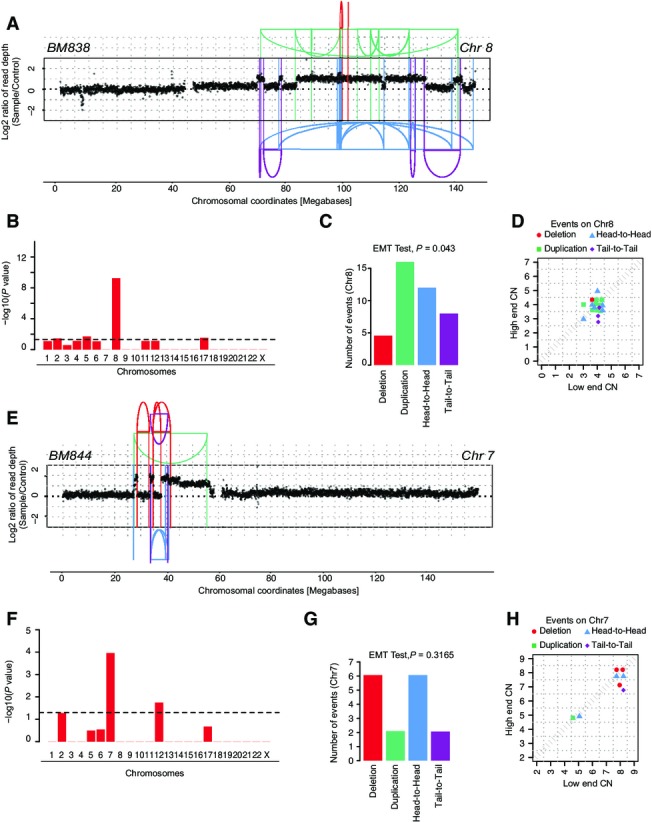
Analysis of chromothripsis cell lines identified post-Zeocin treatment and agar selection
In BM838, derived from hyperploid C29 clone, chromothripsis was observed on chromosome 8. The oscillating pattern of copy numbers and mostly copy number jumps of 0 resulted from a “classical” chromothripsis event with 40 breakpoints, which occurred on a previously unrearranged chromosome. SRs are color-coded based on their orientation: red, deletion type (T-H); green, duplication type (H-T); blue, head-to-head (H-H) type; purple, tail-to-tail (T-T) type.

Statistically significant deviation from null hypothesis of no rearrangement breakpoint clustering in BM838, in line with the occurrence of chromothripsis on chromosome 8. The y-axis shows the -log10(P-value) of KS test applied to each chromosome.

Randomness of SR joins on chromosome 8 (EMT test, P = 0.043). In this sample, we found an apparent tendency of rearrangements to be slightly biased toward duplication-type rearrangements. In the context of the classical pattern of oscillating copy numbers with mostly zero copy number jumps and the strong genome-wide concentration of rearrangements to only this chromosome arm, we did not regard this apparent tendency as evidence against the occurrence of chromothripsis.

Copy number jump distribution between joined fragments of chromosome 8, indicating that chromothripsis occurred on a previously unrearranged chromosome (Li et al, 2014).

In BM844 derived from hyperploid clone C29, we detect chromothripsis on chromosome 7 with 16 breakpoints. A stepwise increase in copy number segments followed by a sharp drop toward the chromosome end was additionally observed, suggesting occurrence of a BFB cycle. SRs are color-coded based on their orientation: red, deletion type (T-H); green, duplication type (H-T); blue, head-to-head (H-H) type; purple, tail-to-tail (T-T) type; gray, inter-chromosomal.

Statistically significant deviation from null hypothesis of no rearrangement breakpoint clustering in BM844, in line with the occurrence of chromothripsis on chromosome 7. The y-axis shows the -log10(P-value) of KS test applied to each chromosome.

Randomness of SR joins on chromosome 7 (EMT test, P = 0.3165) further supporting evidence for chromothripsis.

Copy number jump distribution between joined fragments of chromosome 7. The high CN step distribution might suggest that a number of duplications occurred following chromothripsis, presumably involving 1-2 BFB cycles.